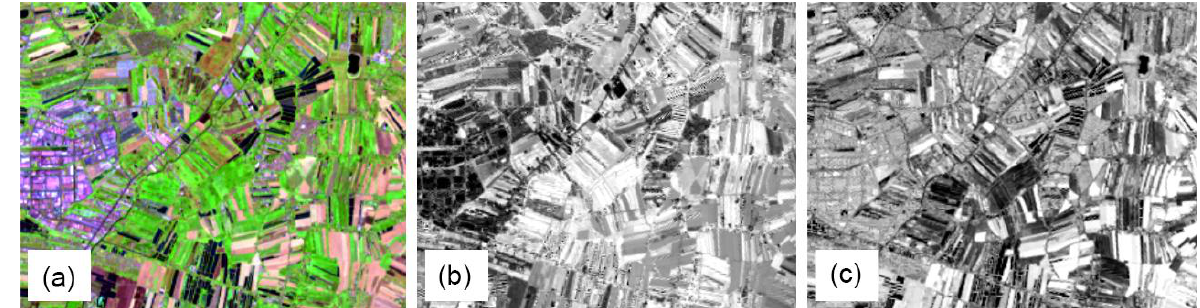
Figure 4. Magnified images ( a ) false-color composite (RGB: 7-5-3) with pink and prune representing built-up and bare soil, ( b ) normalized image on SWIR1 and SWIR2 (Equation (1)), which mostly highlights vegetation with bright tone, bare soil in gray and urban areas in black, and ( c ) three-band bare soil index (Equation (2)) emphasizing bare soil (bright tone), urban features in gray and vegetation in black.